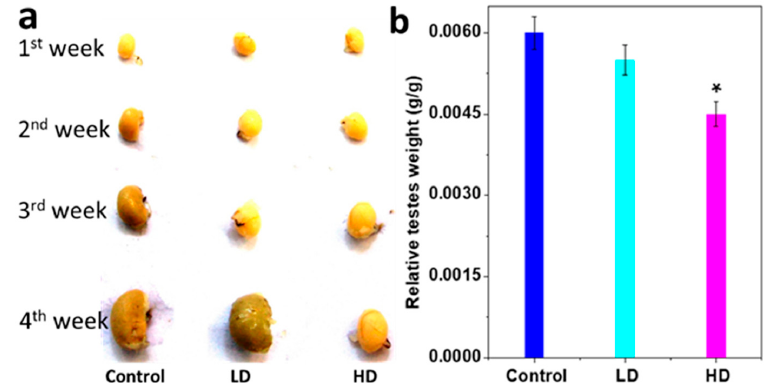
Figure 2. Changes testes response to TCS. ( a ) Representative absolute weekly testes images. ( b ) The histogram results are mean ± S.E.M. of relative testes weight (absolute testes weight / body weight) * significantly di ff erent at p < 0.05 vs.